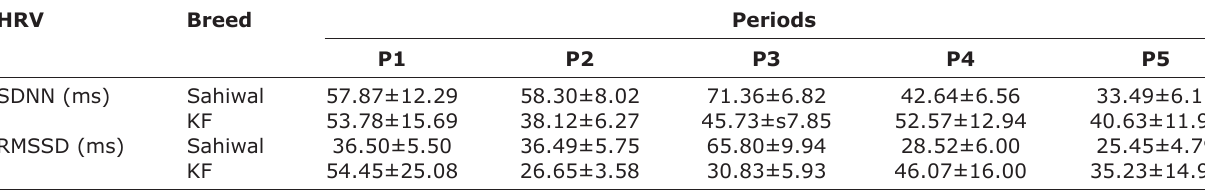
Table-3: SDNN (Mean±SEM) and RMSSD (Mean±SEM) of Sahiwal and KF during different periods of T combinations. HRV Breed